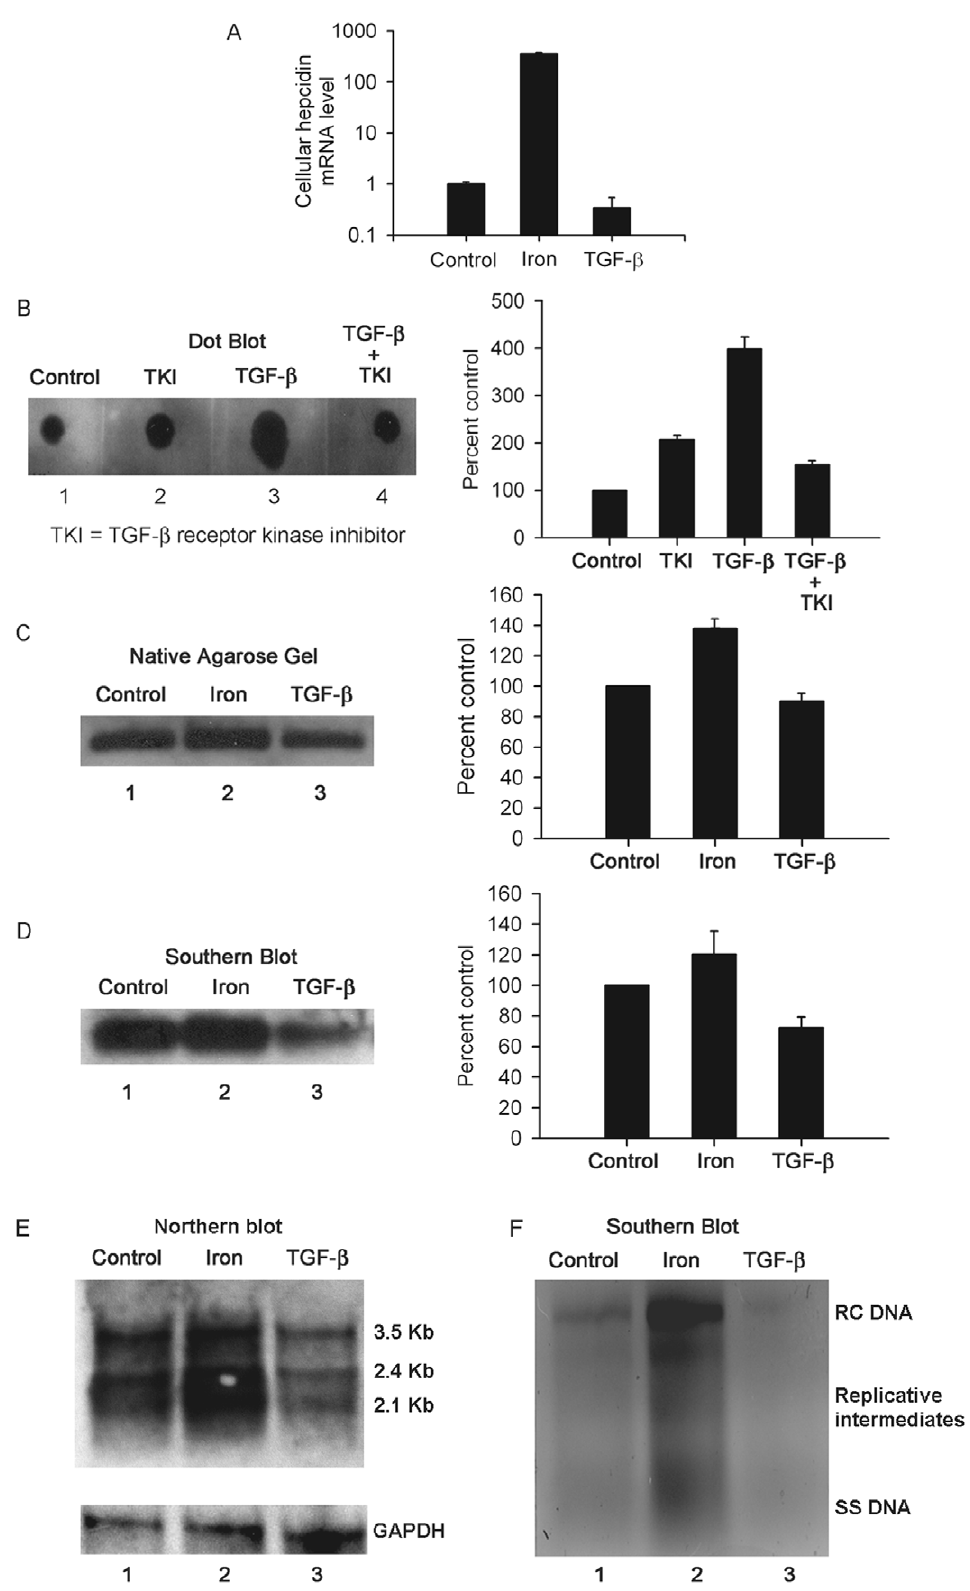
Figure 1. Effects of TGF- b and iron on 2.2.15 cells. Shown are studies with cells cultured in the presence of 20 ng/ml TGF- b or 100 m M iron for 48 h. (A) Hepcidin mRNA expression increased by several-fold in iron-treated cells and not in TGF- b -treated cells. These data are plotted on a natural log scale in comparison with controls. (B) Serine-threonine kinase activity in cells with increase after TGF- b . This increase in kinase activity was blocked